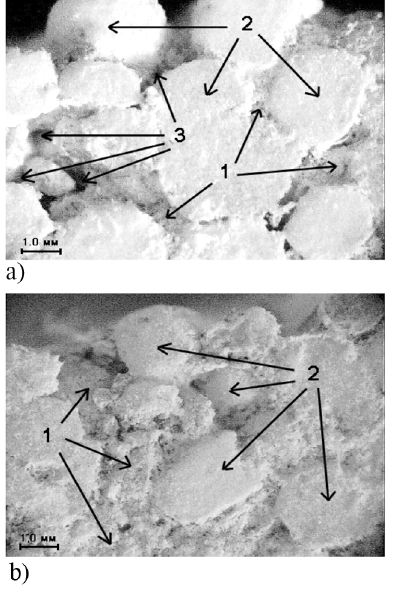
Fig. 4. The surface morphology of lightweight composite of 3 150 kg/m density: a – unstrained; b – strained under load. 1 – porous matrix; 2 – EPS inclusions; 3 – hollows